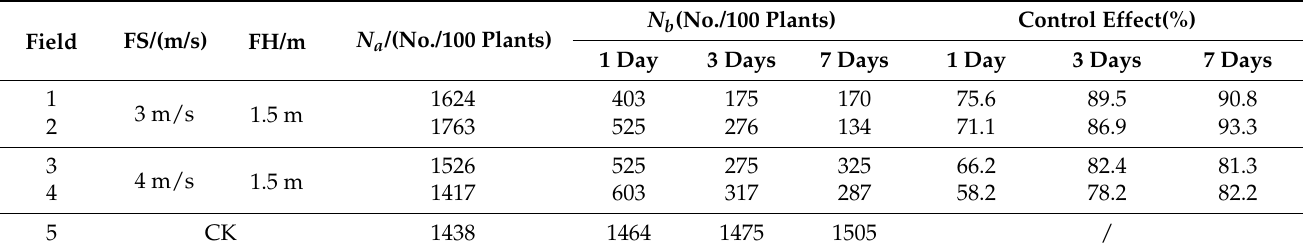
Table 9. Aphid control effect under different operation